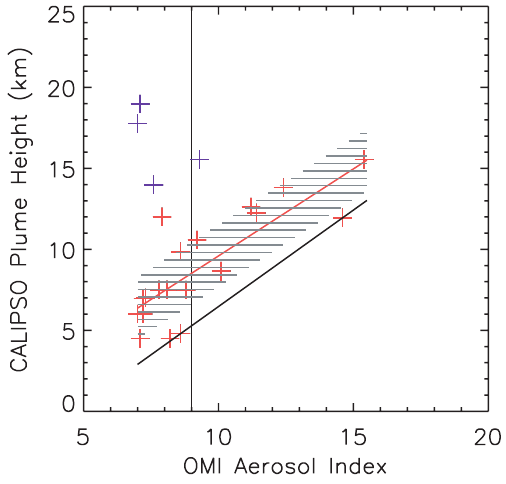
Fig. 2. Flowchart for the determination of highest plume altitude along the CALIPSO track.